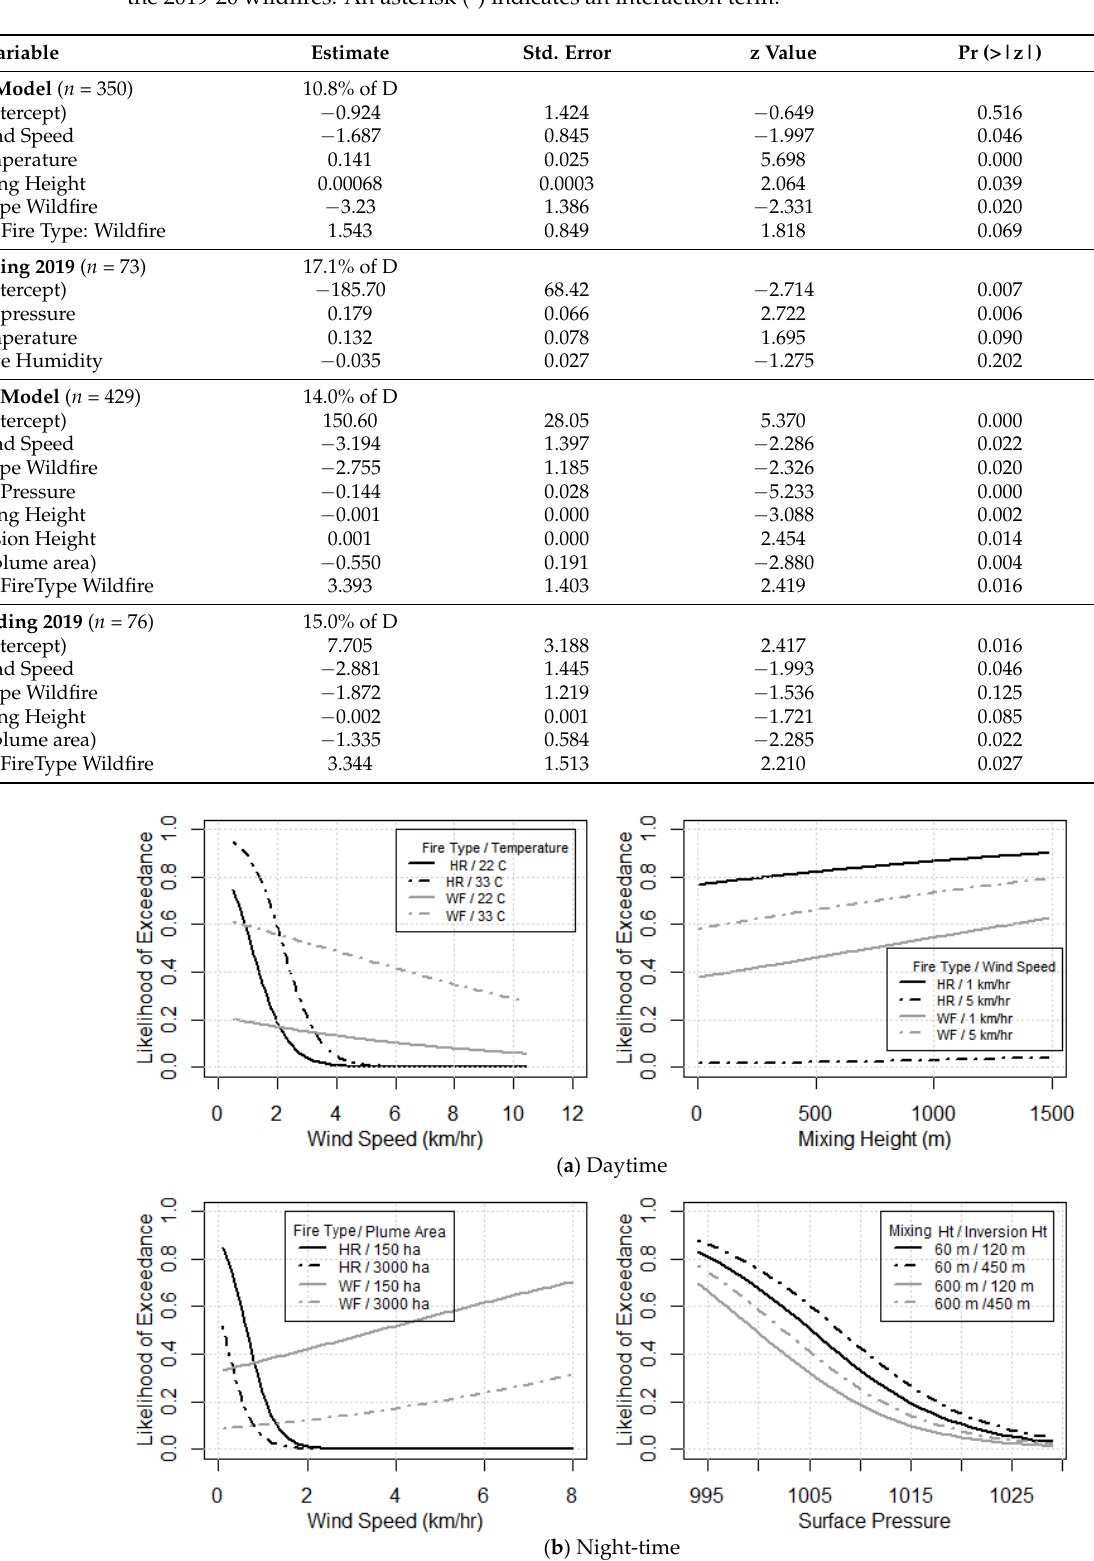
Figure 7. Binomial model relationships for ( a ) daytime and ( b ) night-time poor air quality exceedances.